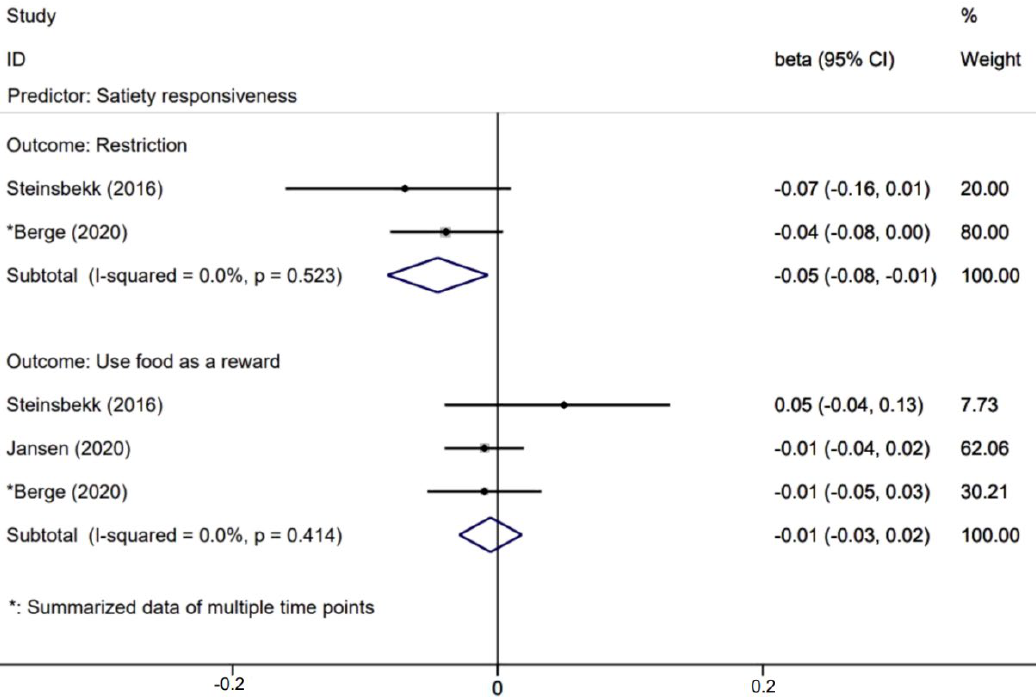
Figure 7. Effects of child satiety responsiveness on parental non-feeding practices.